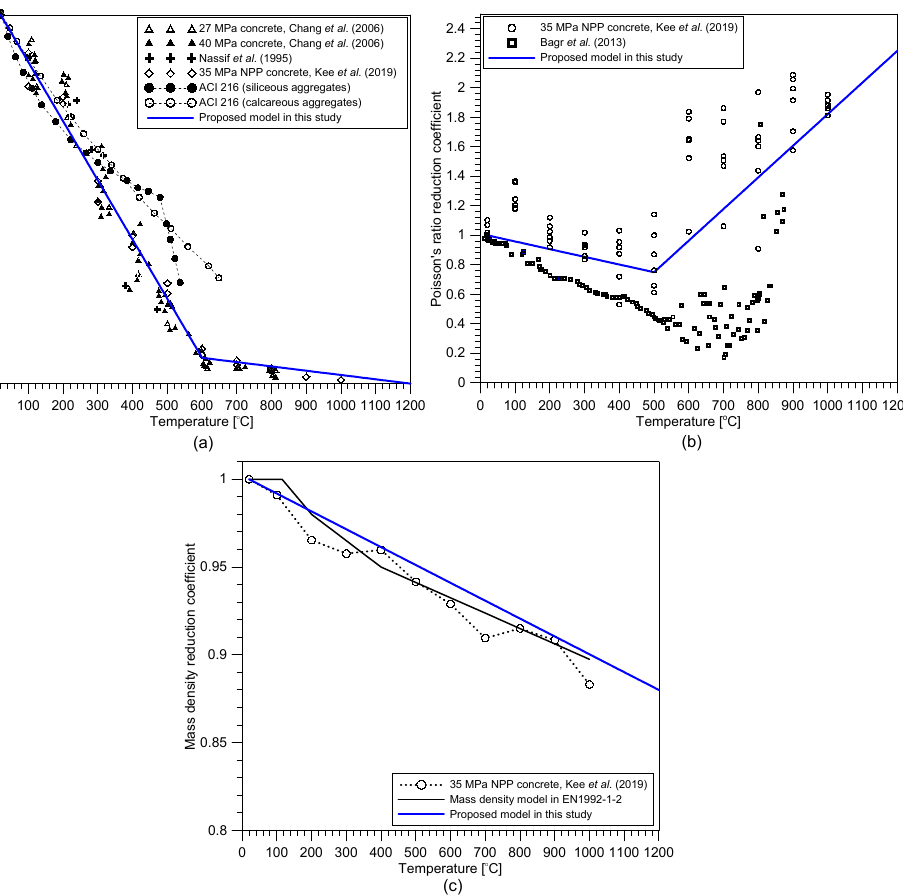
Figure A1. Variations of calibration factors Φ E , Φ ν and Φ ρ that describe the temperature-dependent natures of the three concrete properties: dynamic elastic modulus, E d , dynamic Poisson’s ratio, ν d , and mass density, ρ